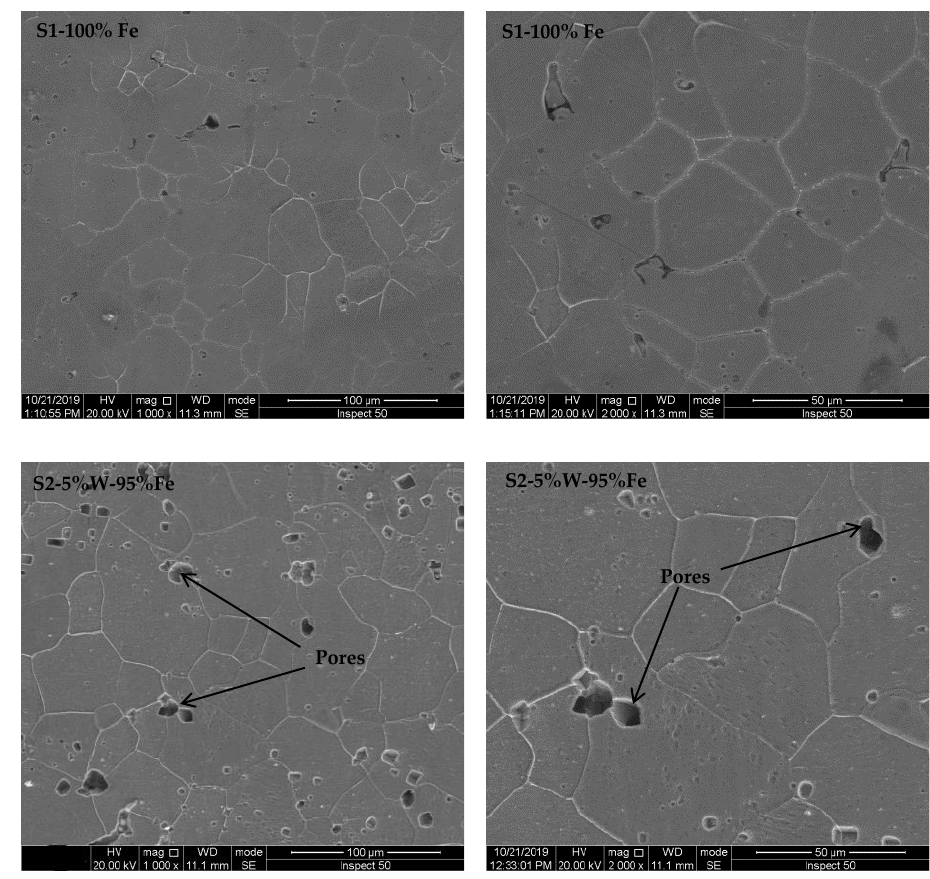
Figure 4. Microstructures of samples 1 and 2 at two different magnifications.